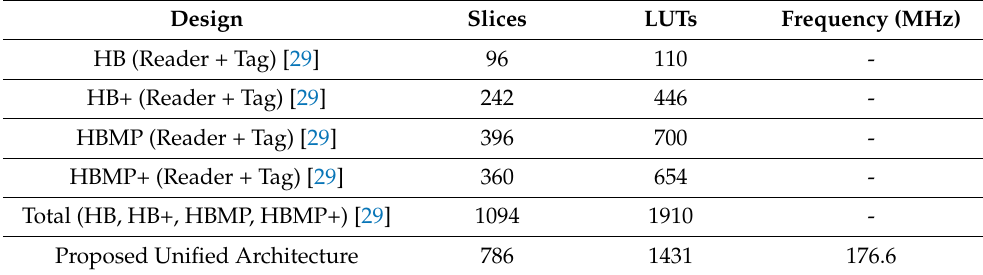
Table 6. Synthesis result for the proposed unified lightweight authentication architecture.